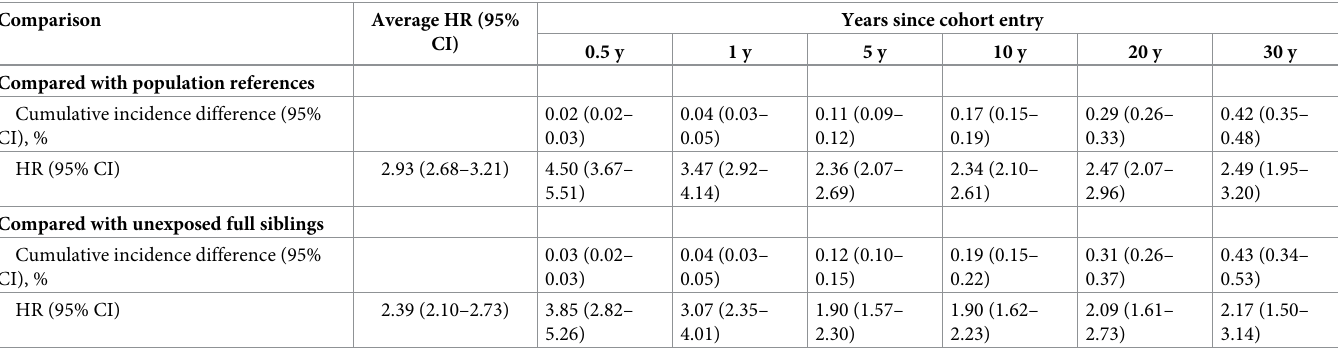
Table 3. CD during follow-up in individuals with an upper GI biopsy result of normal mucosa.